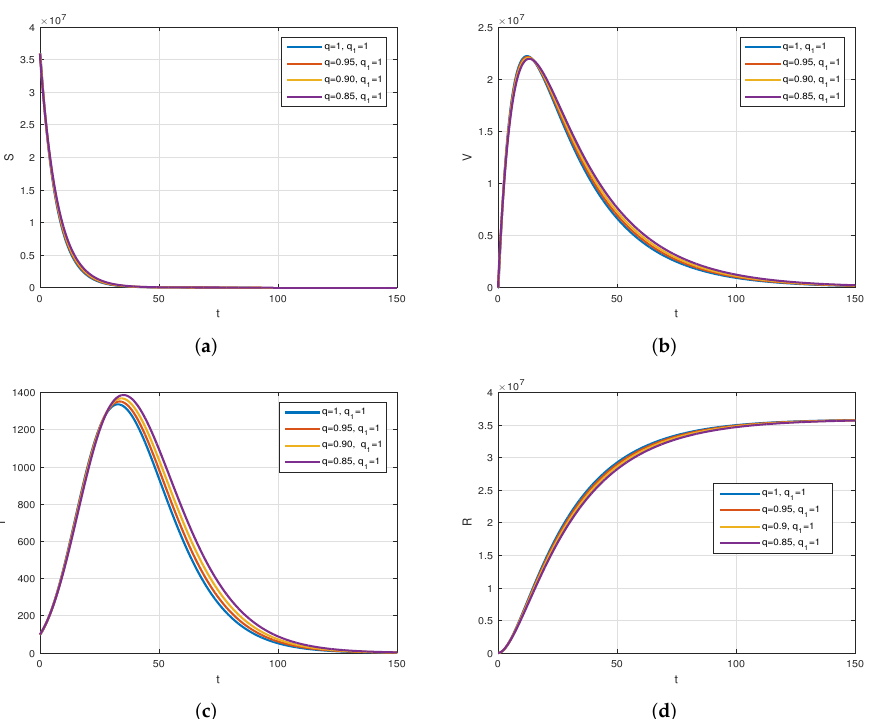
Figure 3. The plot displays the behavior of the model for various values of q and q 1 = 1. Subfigure ( a ) shows the simulation of healthy population when varying q and keeping q 1 fixed. Subfigure ( b ) is the simulation of vaccinated population when q 1 = 1 is fixed and varying q . Subfigure ( c ) shows the simulation of infected population for various values of q and fixed q 1 . Subfigure ( d ) is the simulation of recovered individuals when varying q and fixing q 1